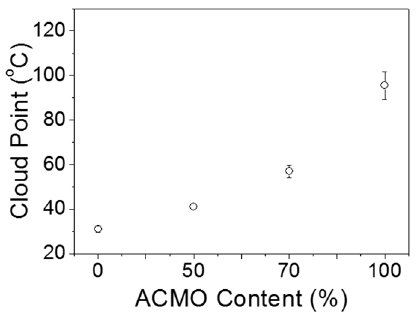
Figure 2. Cloud point measurements of PACMO-PNIPAAM copolymers with four different monomer ratios. The values from multiple measurements were averaged and plotted.